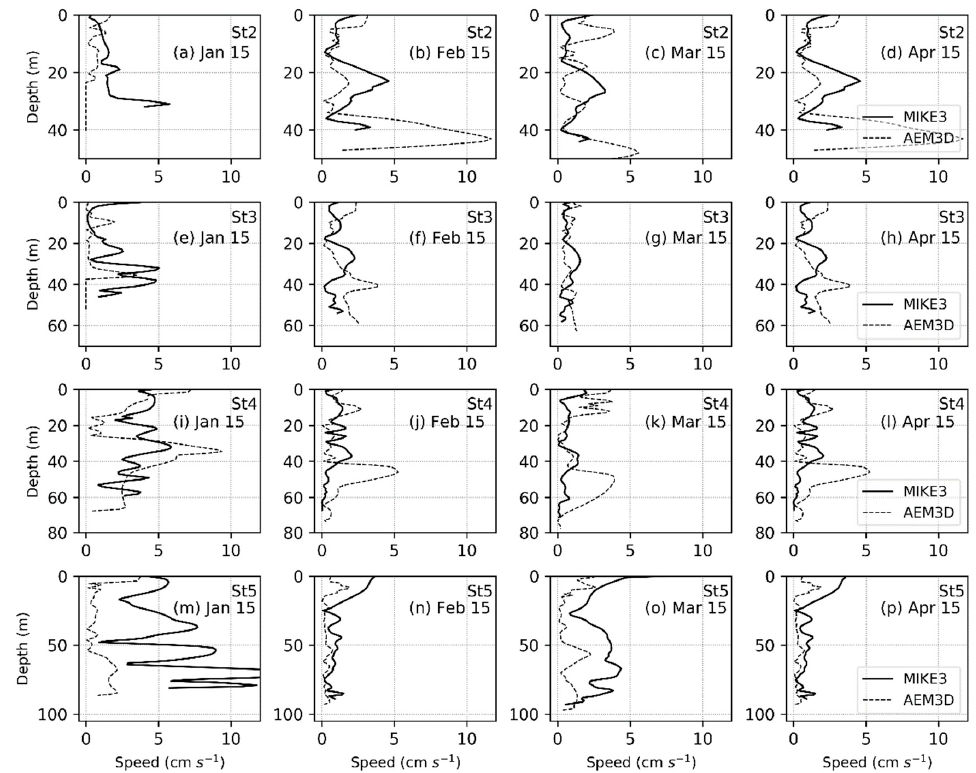
Figure 9. Comparison between MIKE3 (continuous lines) and AEM3D (dashed lines) simulated current speed profiles at different times and locations of the Maroon Reservoir.